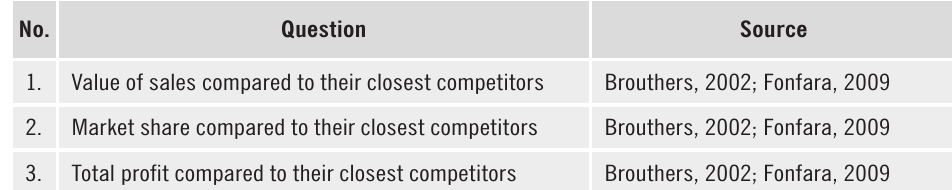
Table 3. Questions concerning the company’s competitiveness from the questionnaire about